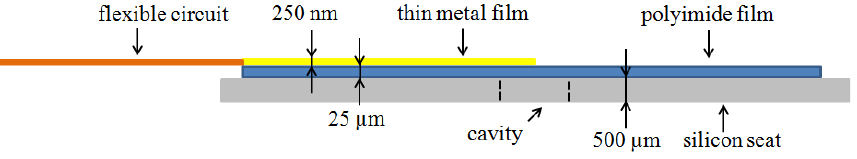
Fig. 2 Cross-sectional view of HF